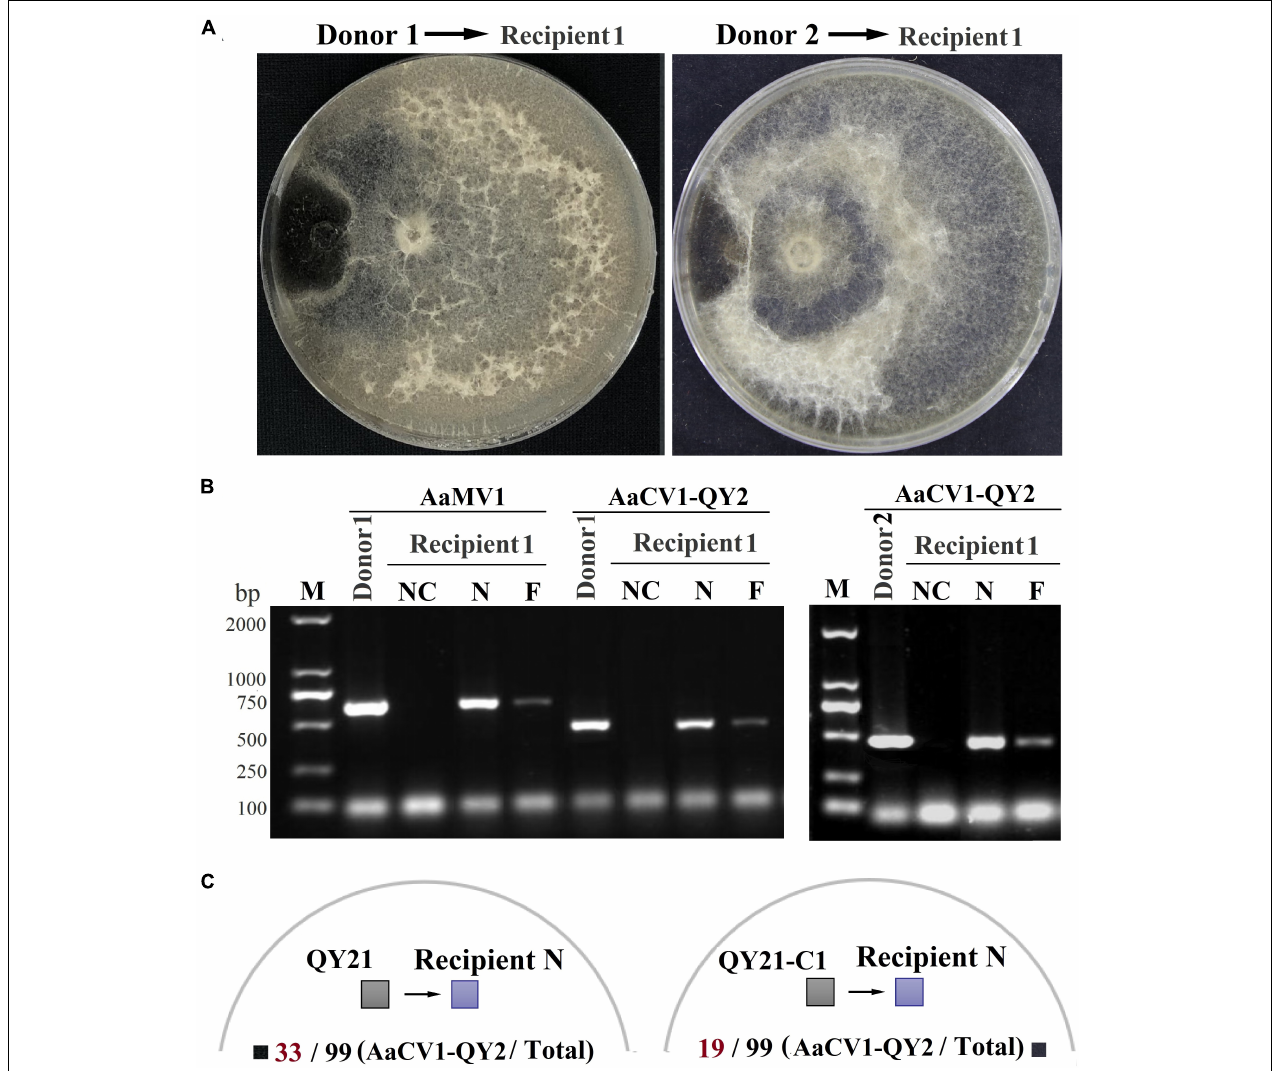
FIGURE 7 | The efficiency of AaCV1-QY2 and AaMV1 horizontal transmission via hyphal anastomosis in A. alternata . The strain QY21 is doubly infected with AaCV1-QY2 and AaMV1; the strain QY21-C1 has eliminated the virus AaMV1 and retains the virus AaCV1-QY2; QY21-C2 strain has completely eliminated all viruses as virus-free. (A) Co-culture on PDA plates of the virus-infected strains QY21 (left) and QY21-C1 (right) as donors and the isogenic virus-free strain QY21-C2 as the recipient, respectively. After 2 weeks of hyphal contact, mycelial plugs were collected from two locations (N: near and F: far distance from the hyphal fusion areas) in the recipient side, transferred onto new PDA plates for dsRNA extraction; NC, negative control. (B) The detection of viral dsRNAs of AaCV1-QY2 or AaMV1 in recipient strains co-cultured with the AaCV1-QY2 + AaMV1-infected strain QY21 (left) and the AaCV1-QY2-infected strain QY21-C1 (right). (C) A schematic diagram of co-culture on PDA plates of the virus-infected strains QY21 (left) and QY21-C1 (right) as donors and the other 99 allogenetic virus-free strains collected from different orchards as recipients. The numbers below the schematic diagram indicate the number of samples with AaCV1-QY2 detected in the total number of